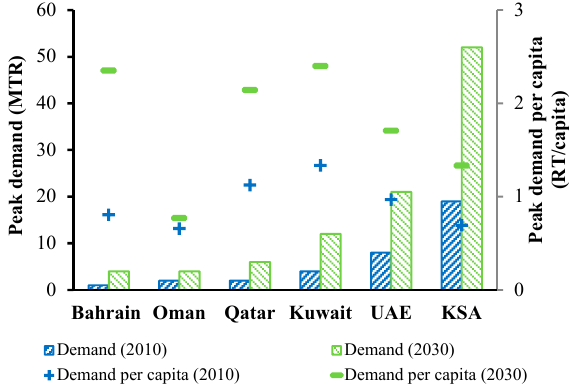
Figure 7. Peak cooling demand (2010–2030) of GCC countries, based on [4,5,128].